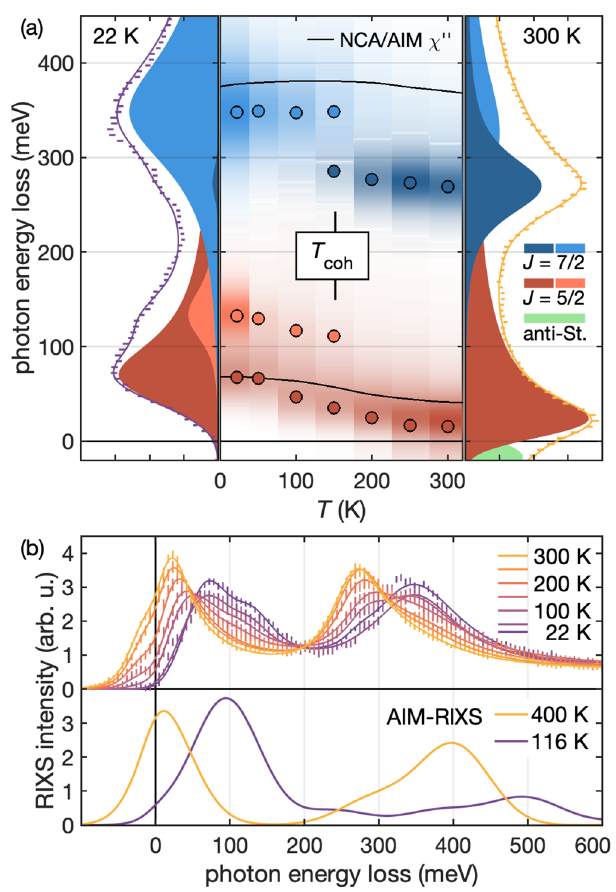
Fig. 4 | Onset of coherence in CePd 3 as observed by resonant inelastic X-ray scattering (RIXS). a Detailed thermal variation of RIXS spectra between 22K and 300K. For clarity, the elastic lines have been subtracted from the data. The emergence of the coherent state at T coh appears as a transfer of intensity between distinct excitations. We phenomenologically model this by Lorentzian fi ts of the data,asindicatedintheleft(22K)andright(300K)panels.Coloredmarkersinthe center panel indicate the centroids of these features. As the J =5/2 quasiparticles become thermally populated, an anti-Stokes peak (green) appears on the photon- energy-gainside.Theblacklinesshowthethermalevolutionofthe J =5/2and J =7/2 peaks in our NCA/AIM calculation of χ ″ (see text for details). b Comparison of temperature-dependent RIXS (top) with the exact AIM-RIXS calculation (bottom). This model accurately captures the parallel shift of J =5/2 and J =7/2 features. The overestimation of the SOgap isanartifact of the necessary discretization (see text for